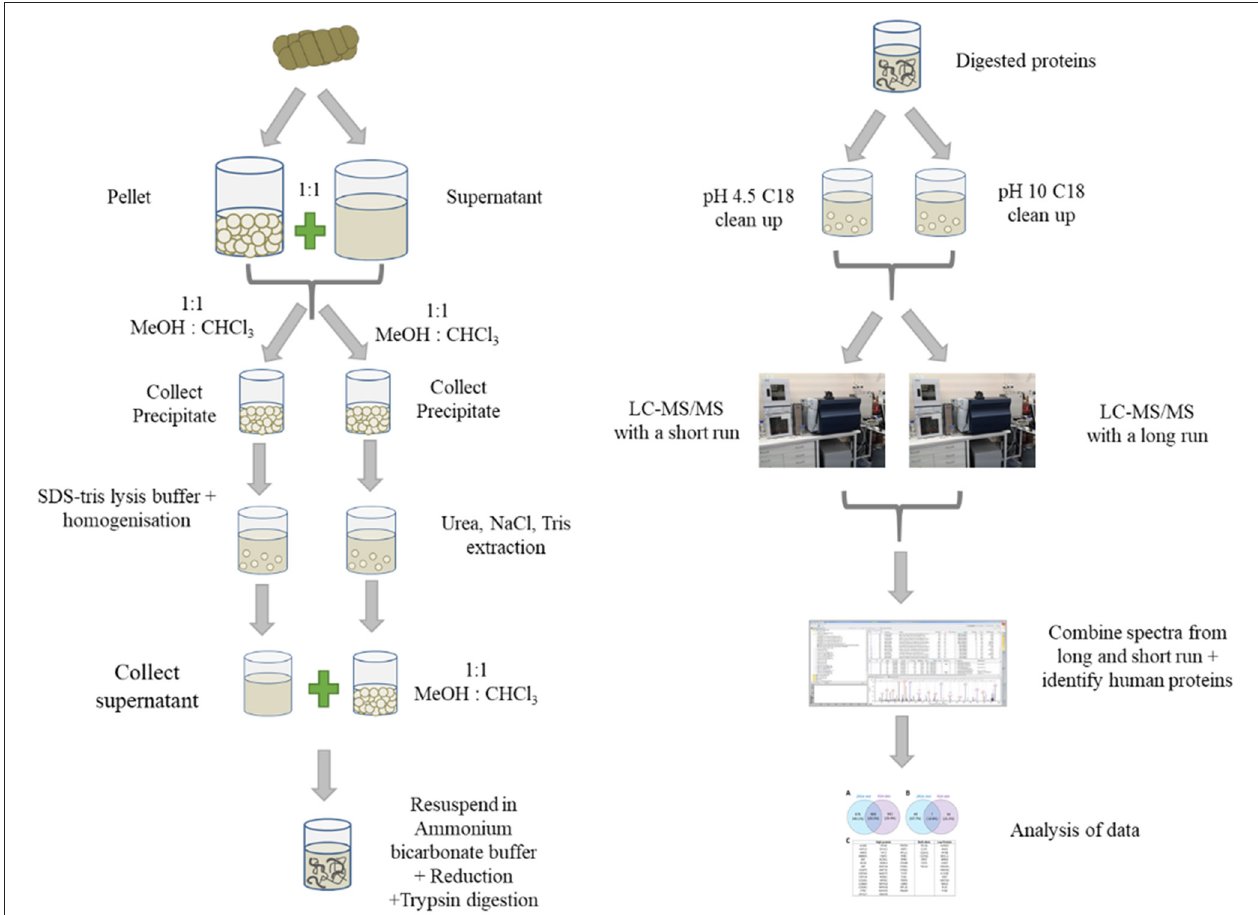
FIGURE 1 | Schematic showing the preparation of faecal samples for proteomics, fractionation, analysis on LC-MS/MS and data